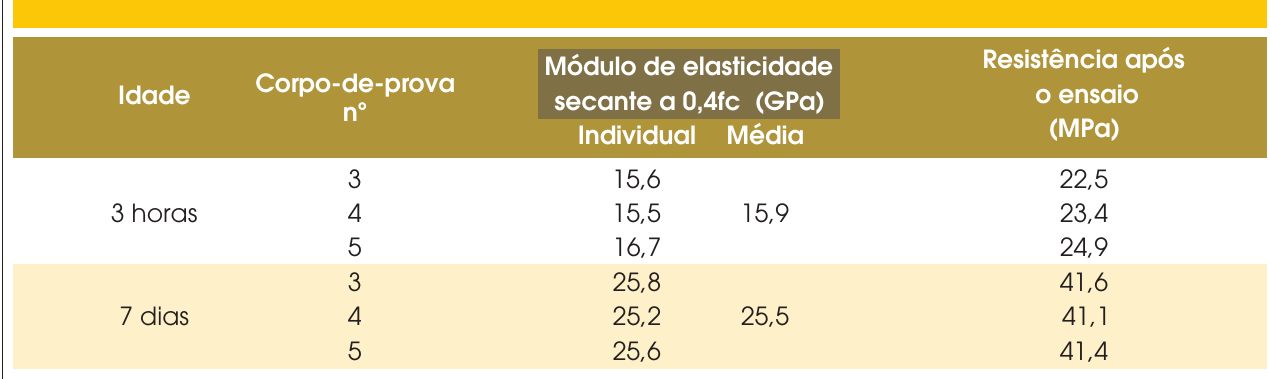
Fig. 3.a. Os registros de vibração (séries temporais) utilizados no Shaker APS foram colhidos de uma ponte de concreto sub - metida a vibrações por tráfego de veículos. Os registros foram realizados com servo-acelerômetros posicionados sobre o ta- buleiro da ponte. A empresa responsável pelas medições foi o LSE - Laboratório de Sistemas Estruturas Ltda. Os dados colhi - dos nessa ponte foram tratados no domínio do tempo e aplica - dos nos ensaios experimentais em laboratório, para um tipo